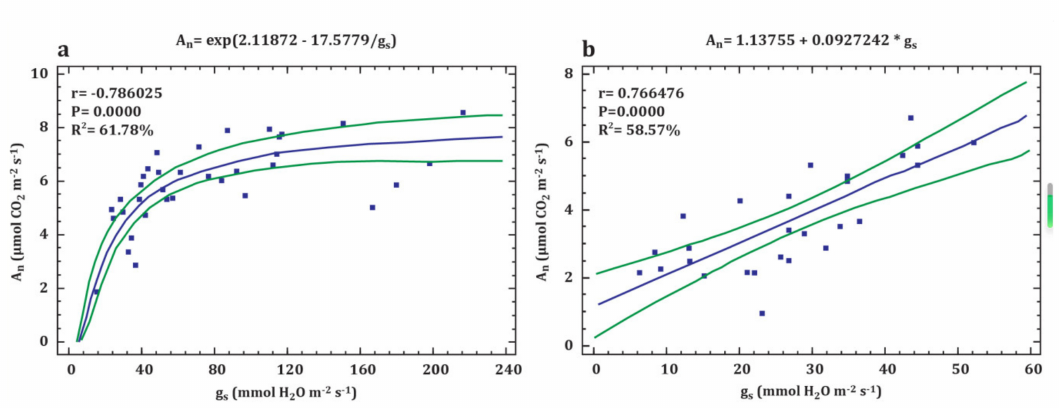
Figure 6. Relationship between the net photosynthetic rate (A n ) and stomatal conductance (g s ) of P. pyraster ( a ) and S. torminalis ( b ) seedlings grown for 50 days under di ff erent water regimes. The plot shows regression curve (blue line) and 95% confidence intervals (green lines). There was a confirmed moderately strong correlation between studied parameters for both tree